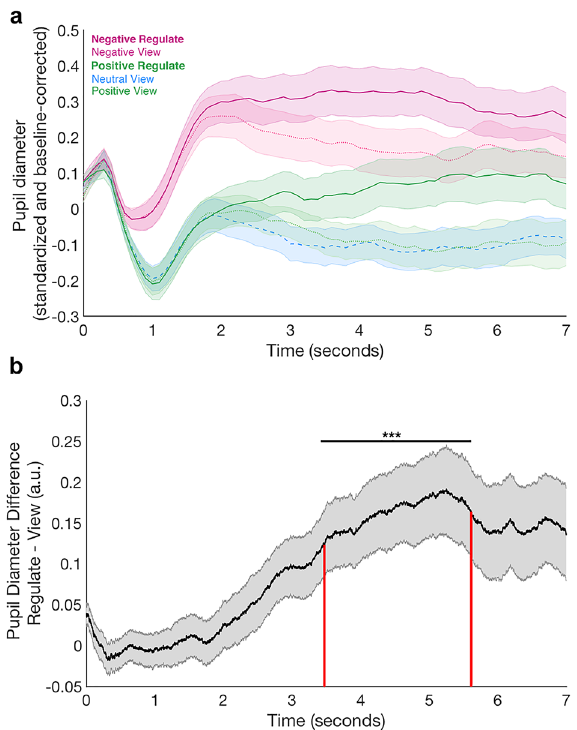
Figure 2. Pupil results. ( a ) Mean pupil dilation during the 7-s regulate (saturated colours) and view periods (lighter colours). The signal across the whole emotion task was z-scored within-participant and baseline- corrected on each trial for the pupil size in the 500 ms prior to the regulation period (during which the phase-scrambled adaptation version of the stimulus was displayed, see “Materials and methods”). The mean pupil dilation was calculated over all 20 trials in each block for each participant and then averaged across the group. The shaded areas indicate the standard error of the mean across participants. Lines denote the mean pupil dilation at each time point. The dotted blue line represents the neutral view condition for comparison. ( b ) Pupil Diameter Difference between Regulation and View Trials. We collapsed over positive and negative blocks in order to test for a valence-independent regulation signal across all participants. The mean z-scored pupil dilation for positive and negative view trials was subtracted from the mean z-scored dilation during positive and negative reappraise trials for each participant. A cluster-based permutation test indicated that between 3.4 and 5.6 s of the reappraisal/view period, the pupil dilation in reappraisal blocks was larger than during viewing blocks (p < 0.001; indicated by the black horizontal line and stars). For each participant, the mean of the Reappraisal – View difference in the pupil dilation signal during this period (marked by the red vertical lines in the plot) determines the Pupil Dilation Index. The shaded areas indicate the standard error of the mean across participants. The black graph denotes the mean pupil dilation at each time